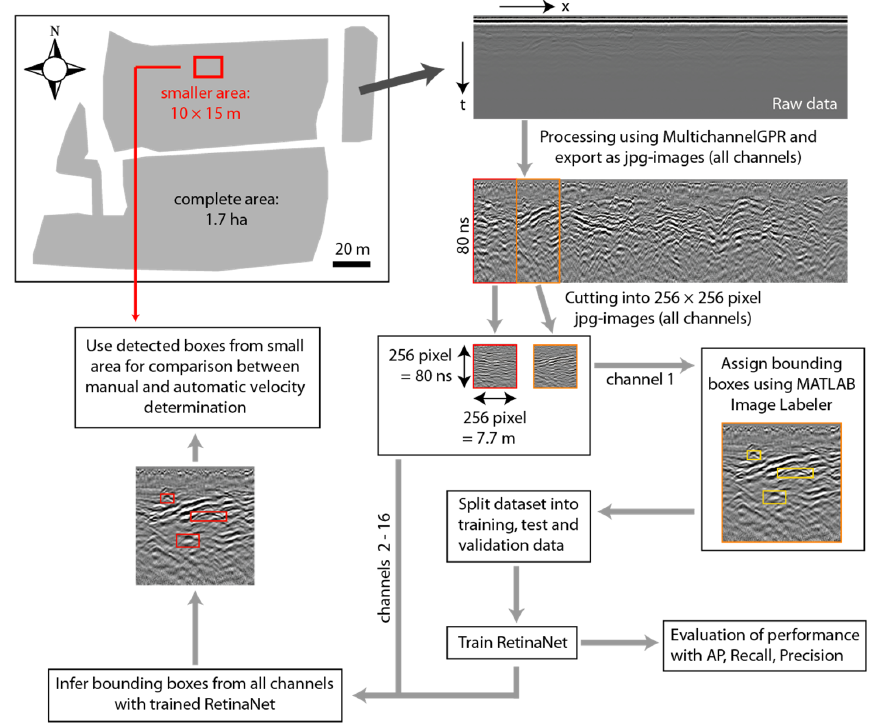
Figure 1. Flowchart showing the preparation of radargrams from the complete area (processing, cutting in images, and labeling), as well as the evaluation and use of the trained RetinaNet. In the end, the detected boxes in the smaller area are used for comparison between manual and automatic velocity determination.